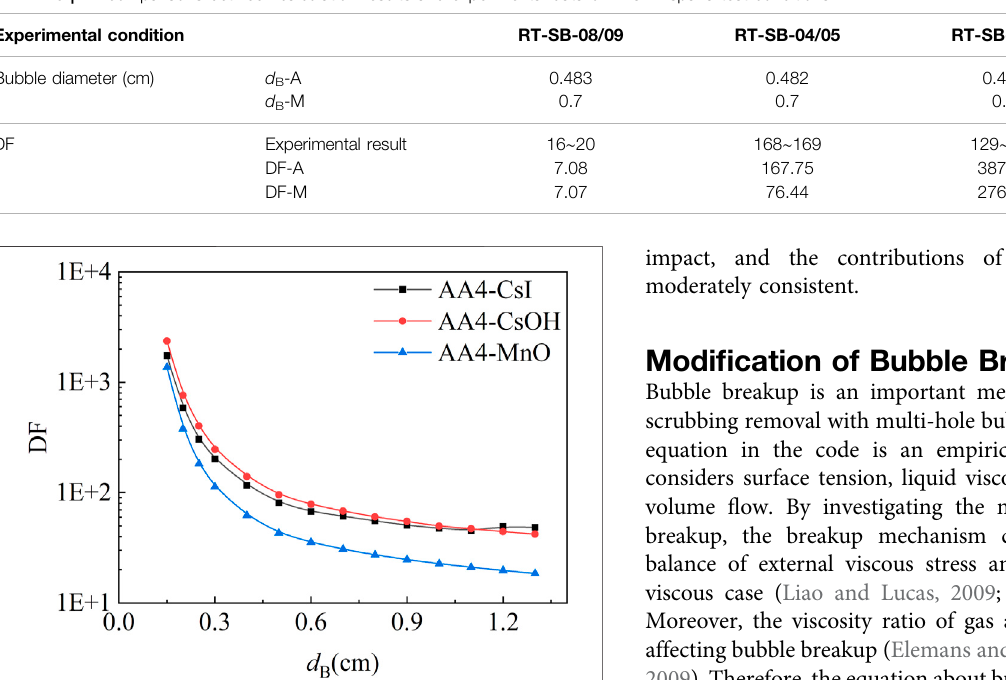
TABLE 5 | DF comparisons between calculation results and experimental data of LACE-Espana test conditions.